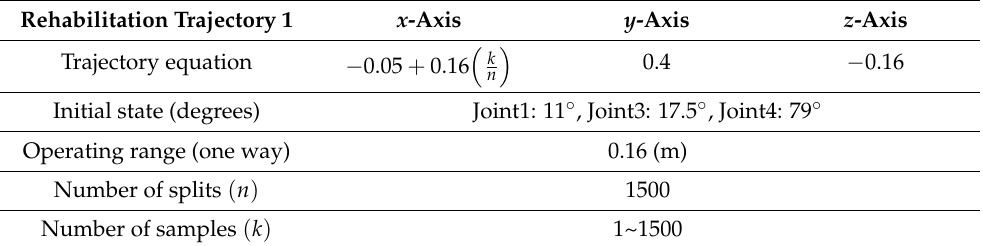
Figure 19. Motion trajectory 2 of each axis of the robot arm is planned by kinematics.